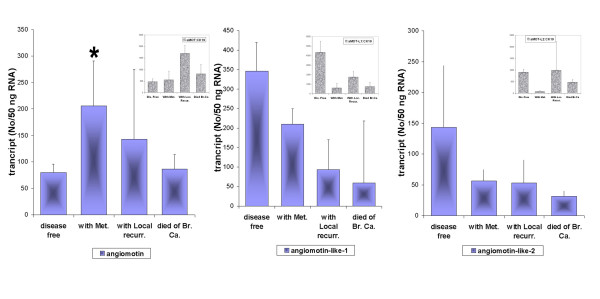
Angiomotins and clinical outcomes. Patients were assessed based on the outcome after 10 years from initial surgery, and were divided into those who remained disease free, with metastasis, with local recurrence and who died of breast cancer related causes. Inserts: respective angiomotin transcript:CK19 transcript ratio. * p = 0.03 vs disease free group.